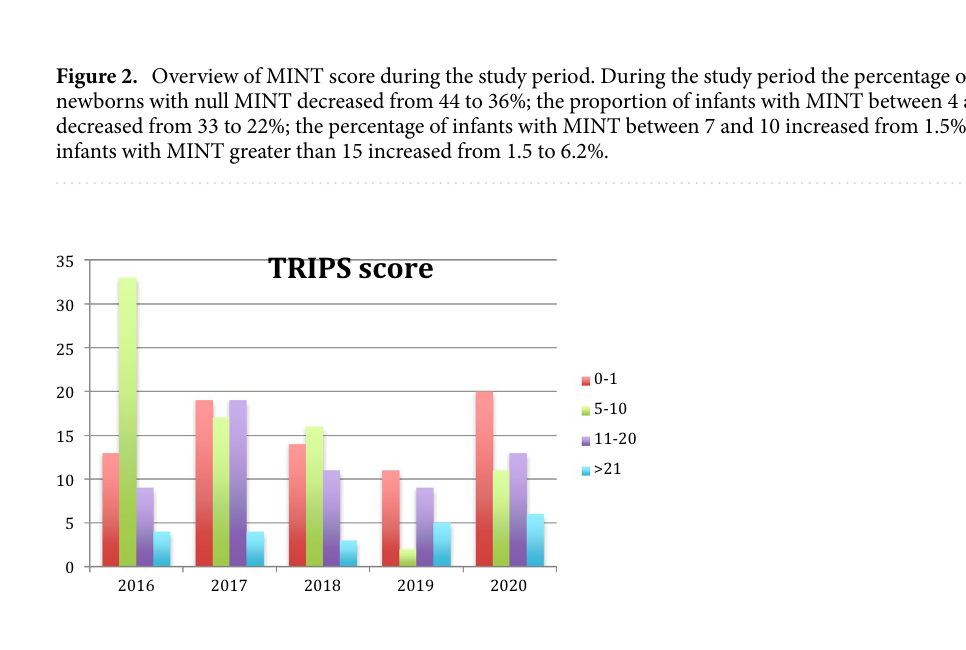
Figure 3. Changes in TRIPS score during the study period. Data regarding the TRIPS score during the study period, show an increase of infants with TRIPS 0–1 from 19 to 31%, the proportion of infants with TRIPS 5–10 reduced from 50 to 17%, the proportion of infants with TRIPS 11–20 increased from 13 to 20%, as well as the proportion of infants with TRIPS > 21 from 6 to